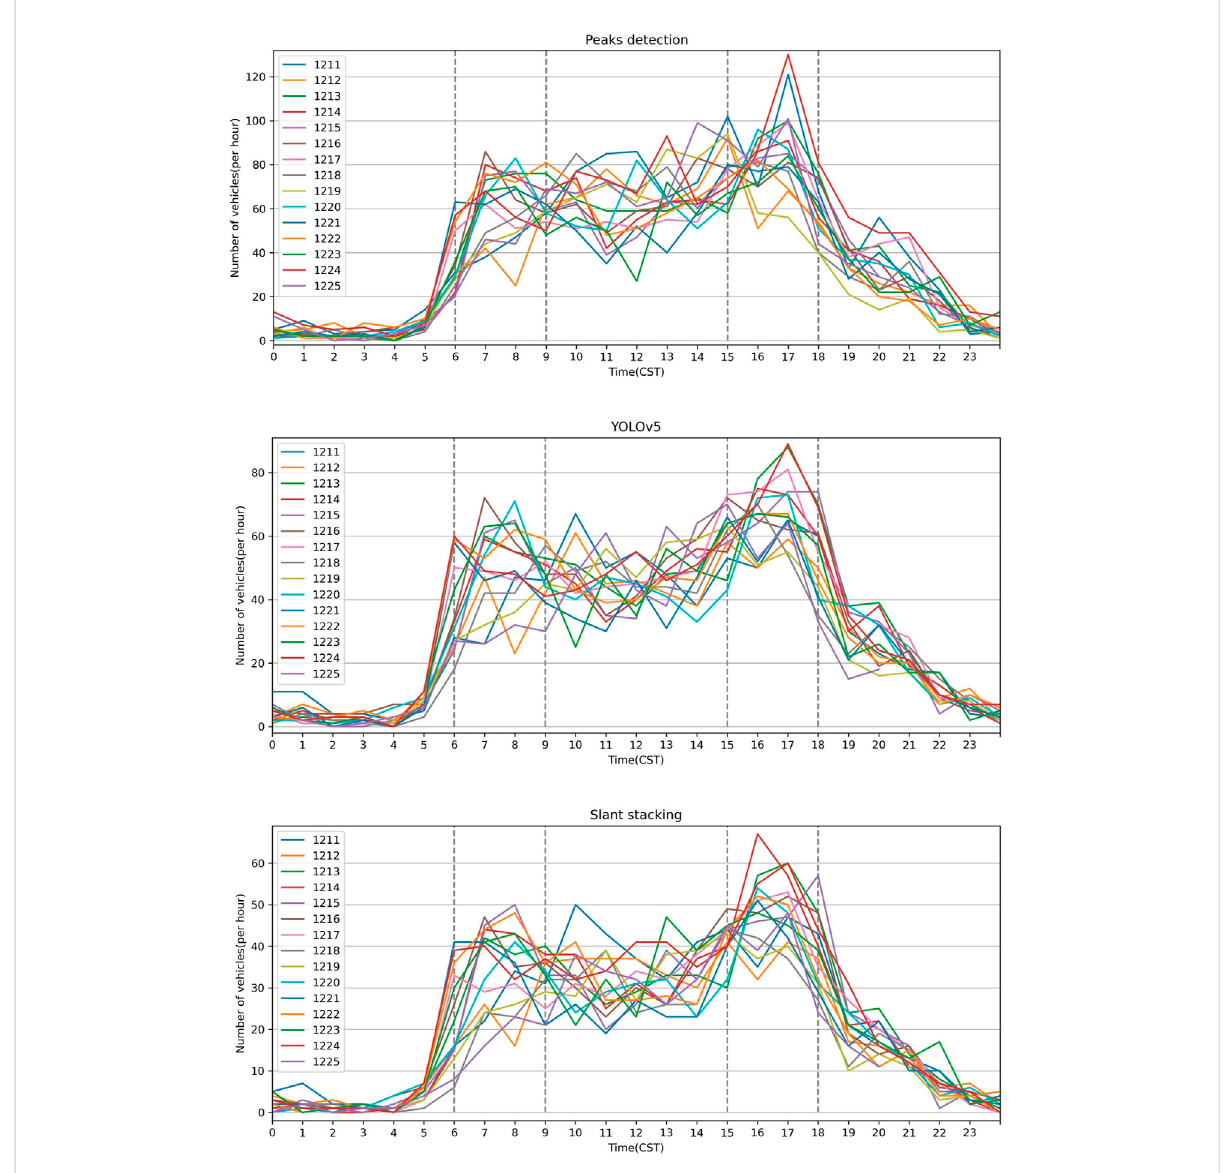
FIGURE 7 Hourly traf fi c volumes of 15 days derived from three detection methods. Different colored lines correspond to each day, and the gray vertical dot lines represent the rush